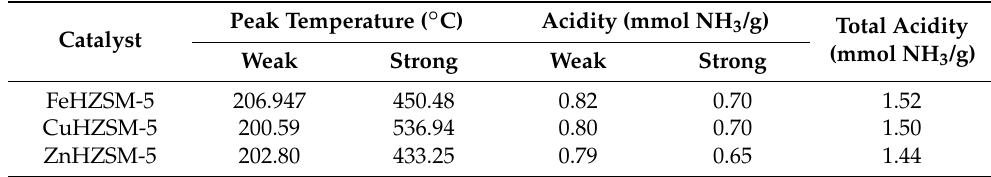
Figure 5. NH 3 -TPD for 4 wt. % FeHZSM-5, 4 wt. % CuHZSM-5 and 4 wt. % ZnHZSM-5 catalysts. Table 2. NH 3 -TPD results for 4 wt. % FeHZSM-5, 4 wt. % CuHZSM-5 and 4 wt. % ZnHZSM-5 catalysts.